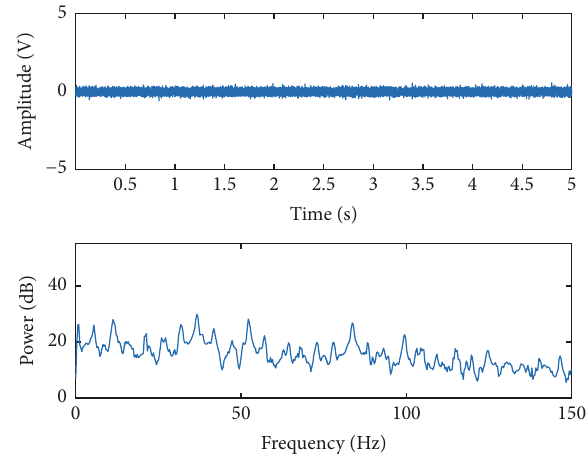
Figure 12: Received signal and power spectrum when the trans- ducer frequency is 5Hz and flow meter value is 0.13 m/s, in the absence of bubbles.